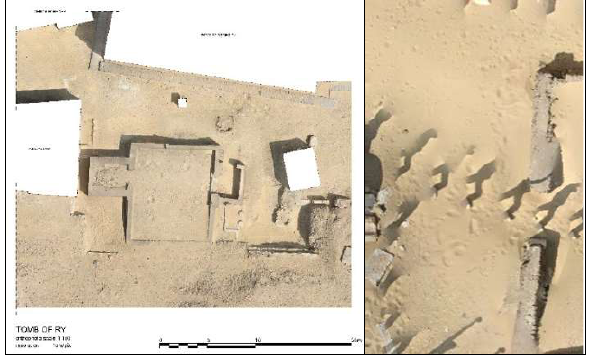
Figure 8. Orthomosaic extracted from a small portion of the DSM (left), original results of the orthorectification (right).